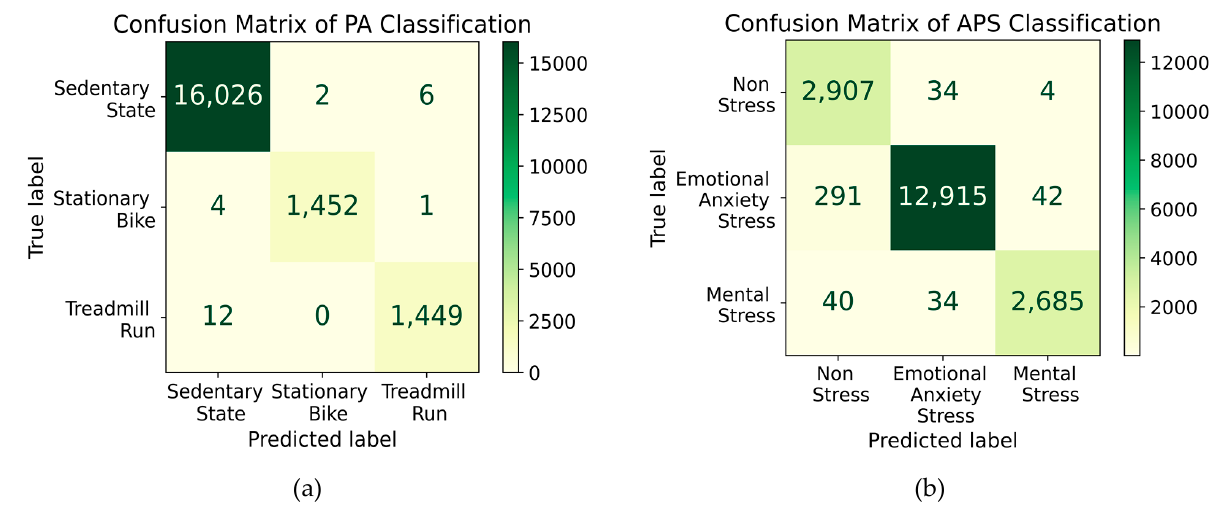
Figure 12. ( a ) Confusion matrix of PA types classification using the independent XGBoost classifi- cation (class imbalance mitigated by ADYSN); ( b ) Confusion matrix of APS types classification using the independent XGBoost (ADYSN).